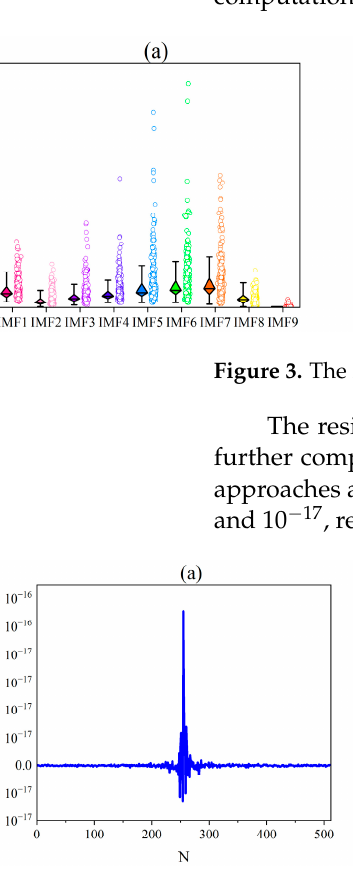
Figure 4. Residual noise from: ( a ) CEEMDAN ( b ) ICEEMDAN and ( c ) CCERLMDAN.